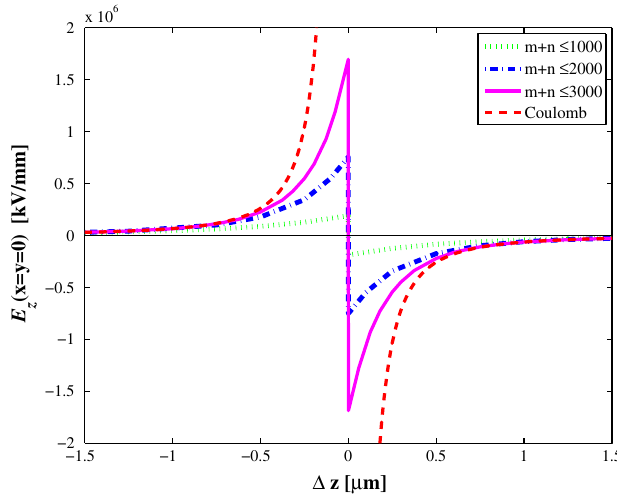
FIG. 6. (Color) Longitudinal electric field